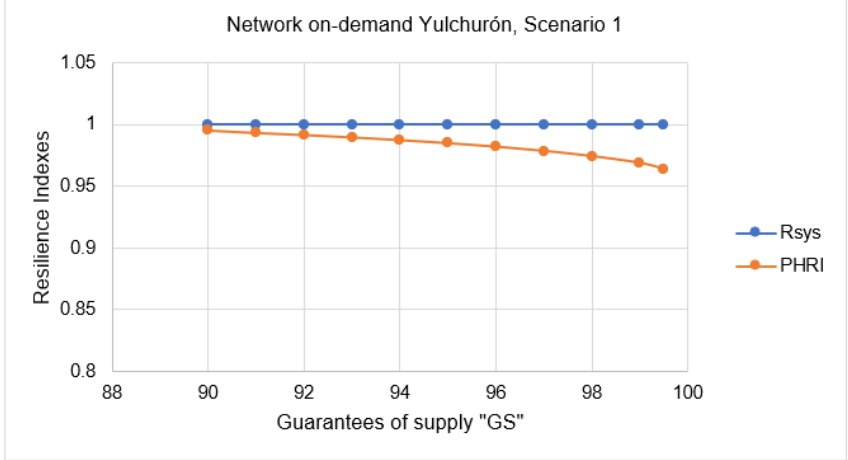
Figure 11. “Rsys” and “PHRI” results, in scenario 1 on-demand.